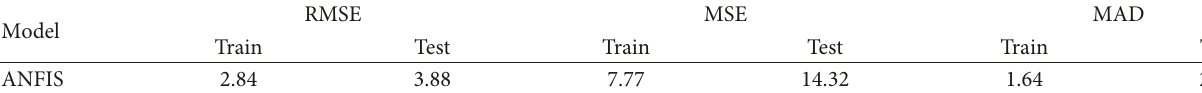
Table 6: RMSE, MSE, and MAD errors in the ANFIS network.